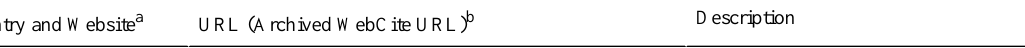
Table 1. Brief descriptions of reviewed